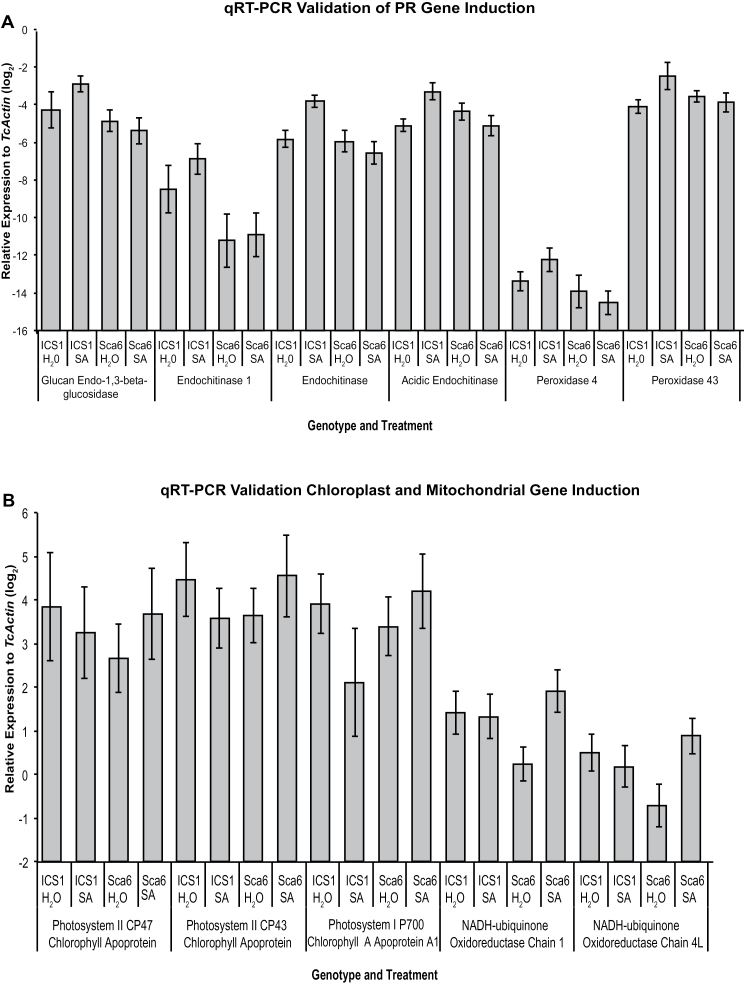
Comparison of transcript levels of select genes from ICS1 and SCA6 genotypes and SA and water (control) treatments as detected by qRT-PCR. Each bar represents the mean of nine samples ±SE (three replicated from each developmental stage). Values are calculated relative to TcActin. (A) Effect of SA treatment on cacao PR genes. (B) Effect of SA treatment on cacao genes with Arabidopsis best hits encoded in chloroplasts and mitochondria. Primer sequences are provided in Supplementary Table 10.